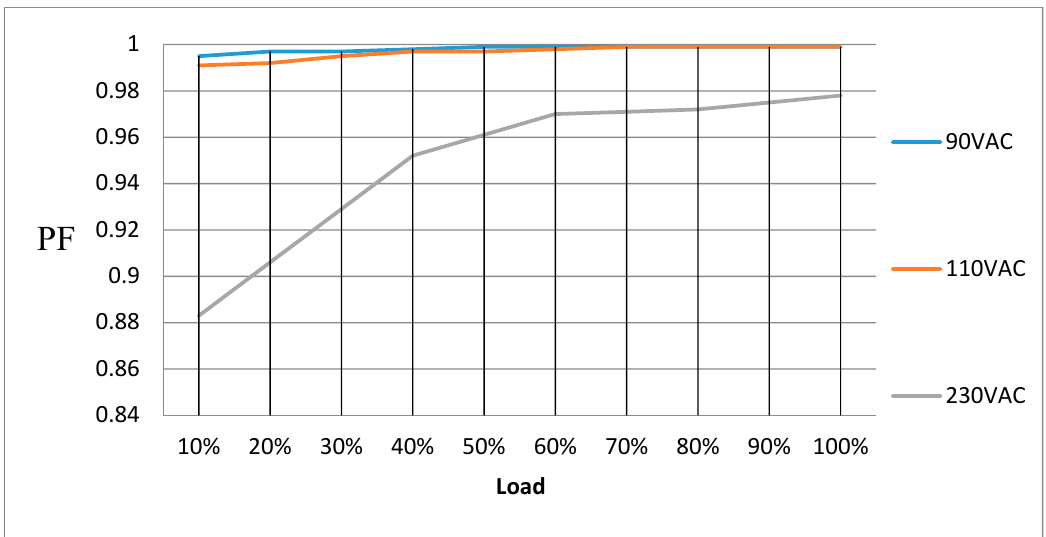
Figure 16. Plots of the power factor of the proposed interleaving bridgeless boost converter from light load to heavy load under different input voltages.